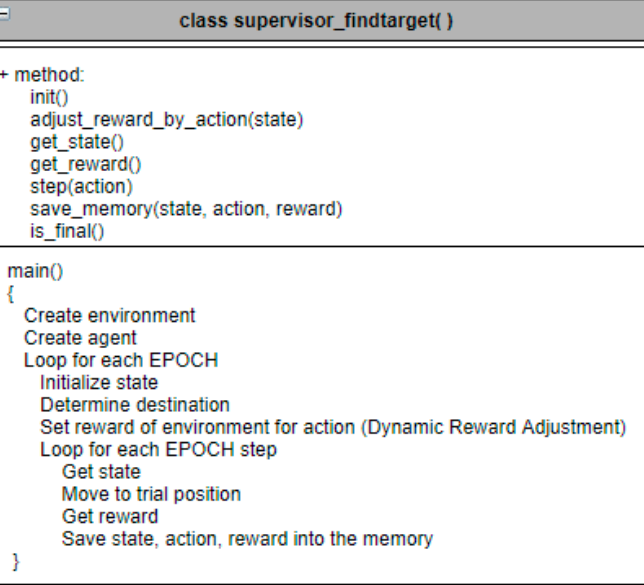
Figure 7. Required methods and logic of path finding [25].